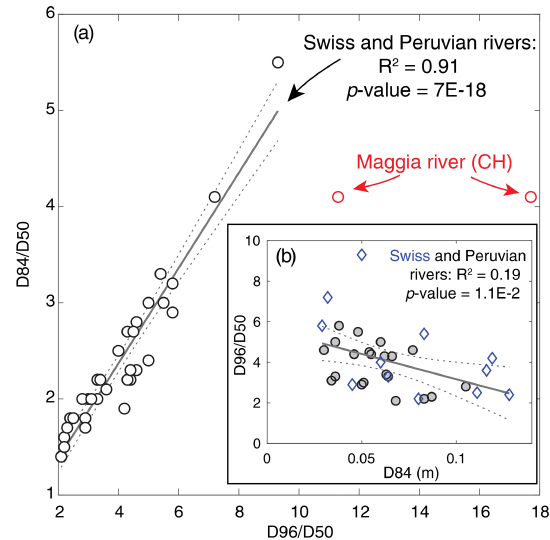
Figure 2. (a) Relationship between ratio of the D 96 /D 50 and D 84 /D 50 , implying that the D 96 grain sizes of the Maggia gravel bars are too large if the D 50 is taken as reference and if the other gravel bars are considered. (b) Relationships between D 84 and sort- ing, expressed by the D 96 /D 50 ratio. The Maggia data are not con- sidered in this figure. However, the negative correlation between these variables is weak. Blue diamonds correspond to the Swiss rivers, while grey circles are Peruvian